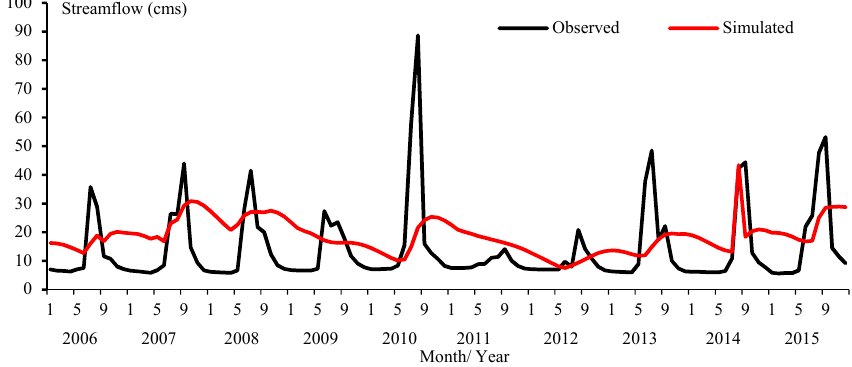
Figure 4. Non-calibrated Soil and Water Assessment Tool (SWAT) model simulated monthly streamflow at the outlet of the middle reach.